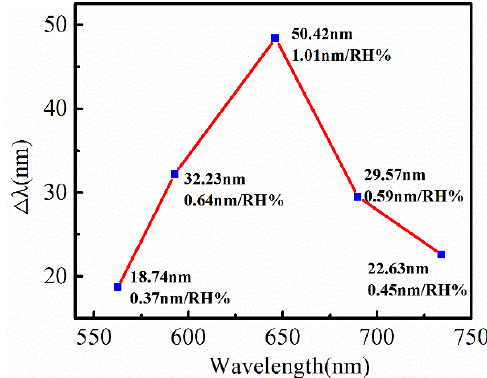
Figure 3. Averaged RH sensitivities of the fiber SPR sensor with different initial wavelengths (or thicknesses of the PVA film).